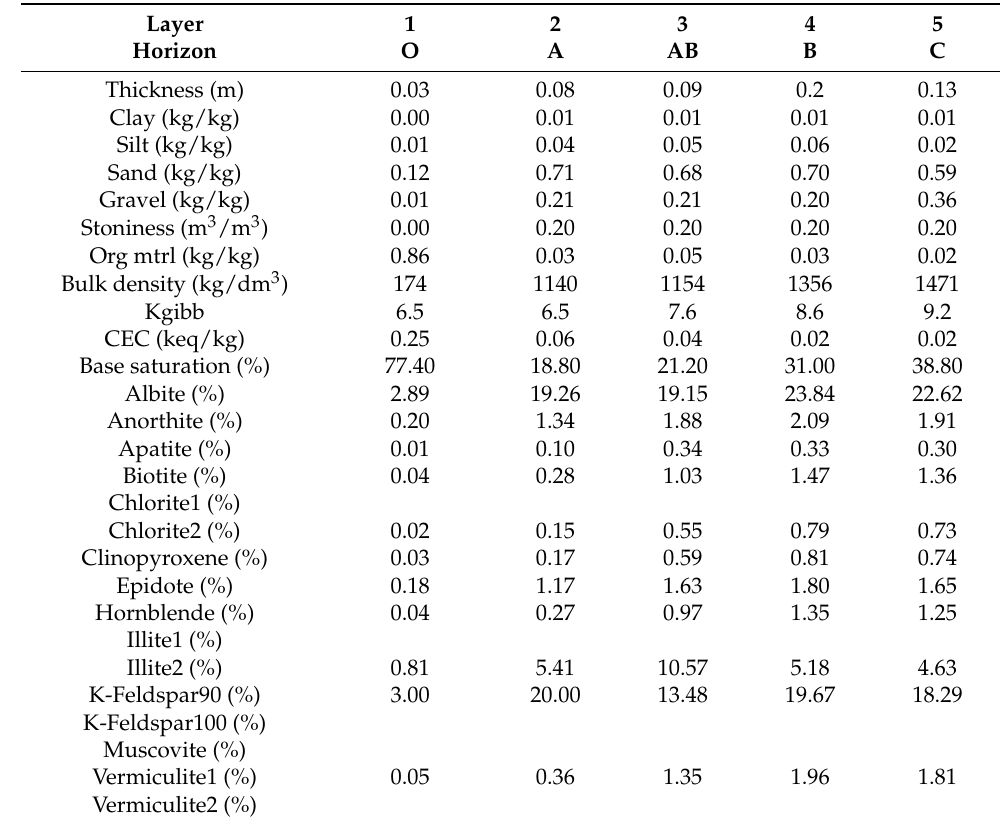
Table A2. Soil parameters for the Northern site.